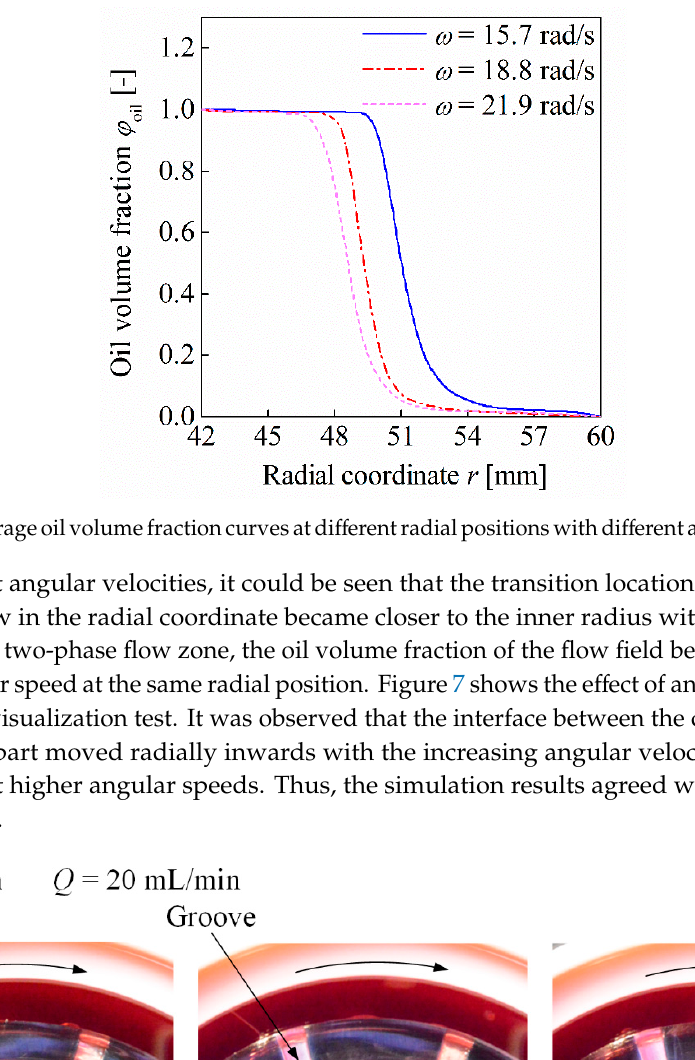
Figure 7. Comparison of the air–oil interface radial position at different angular velocities.